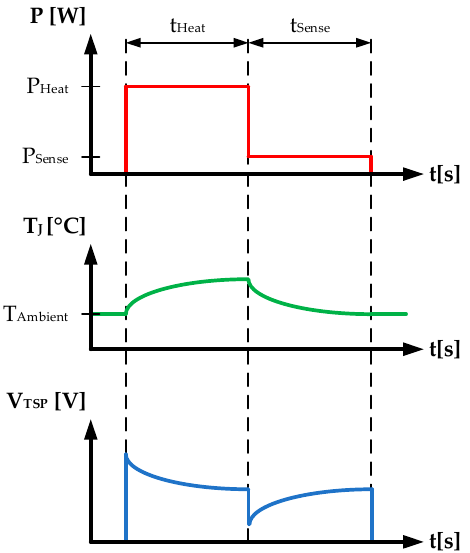
Figure 3. Measurement sequence for transient thermal analysis (TTA) with course of power P , junction temperature T J , and voltage of temperature-sensitive parameter V TSP .